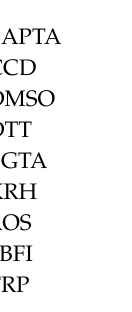
Figure S1 . α -, γ - and δ -tocopherol isomers induce acute cytosolic Ca 2 + increases at 2.5 µ M in Caco-2 cells. Figure S2 . Time course of α -tocotrienol exposure on cytosolic Ca 2 + levels and HyPer signal in Caco-2 cells. Figure S3 . Comparison of the magnitude of calcium responses induced by α -, γ - and δ -tocopherol at 3 and 6 min of exposure. Figure S4 . α -, γ - and δ -tocopherol isomers elicit similar e ff ects on the HyPer biosensor at 50 µ M in Caco-2